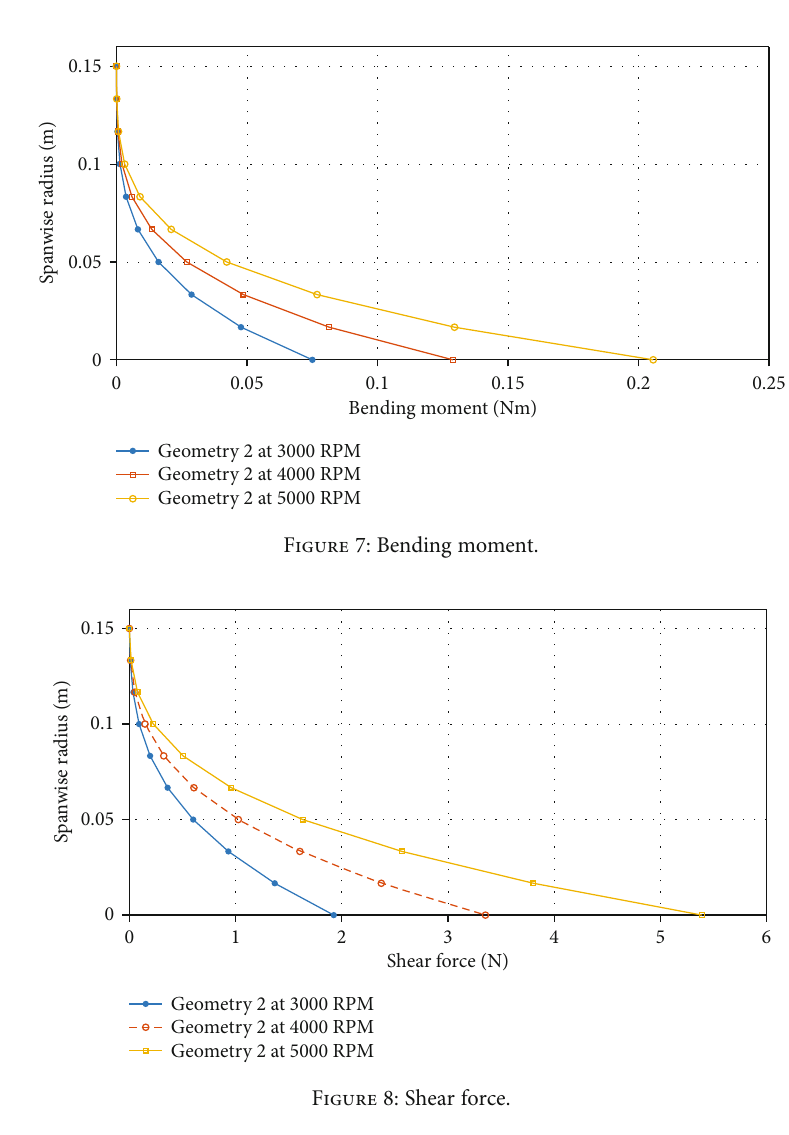
Figure 6: Variation of twist angle for three di ff erent velocities.